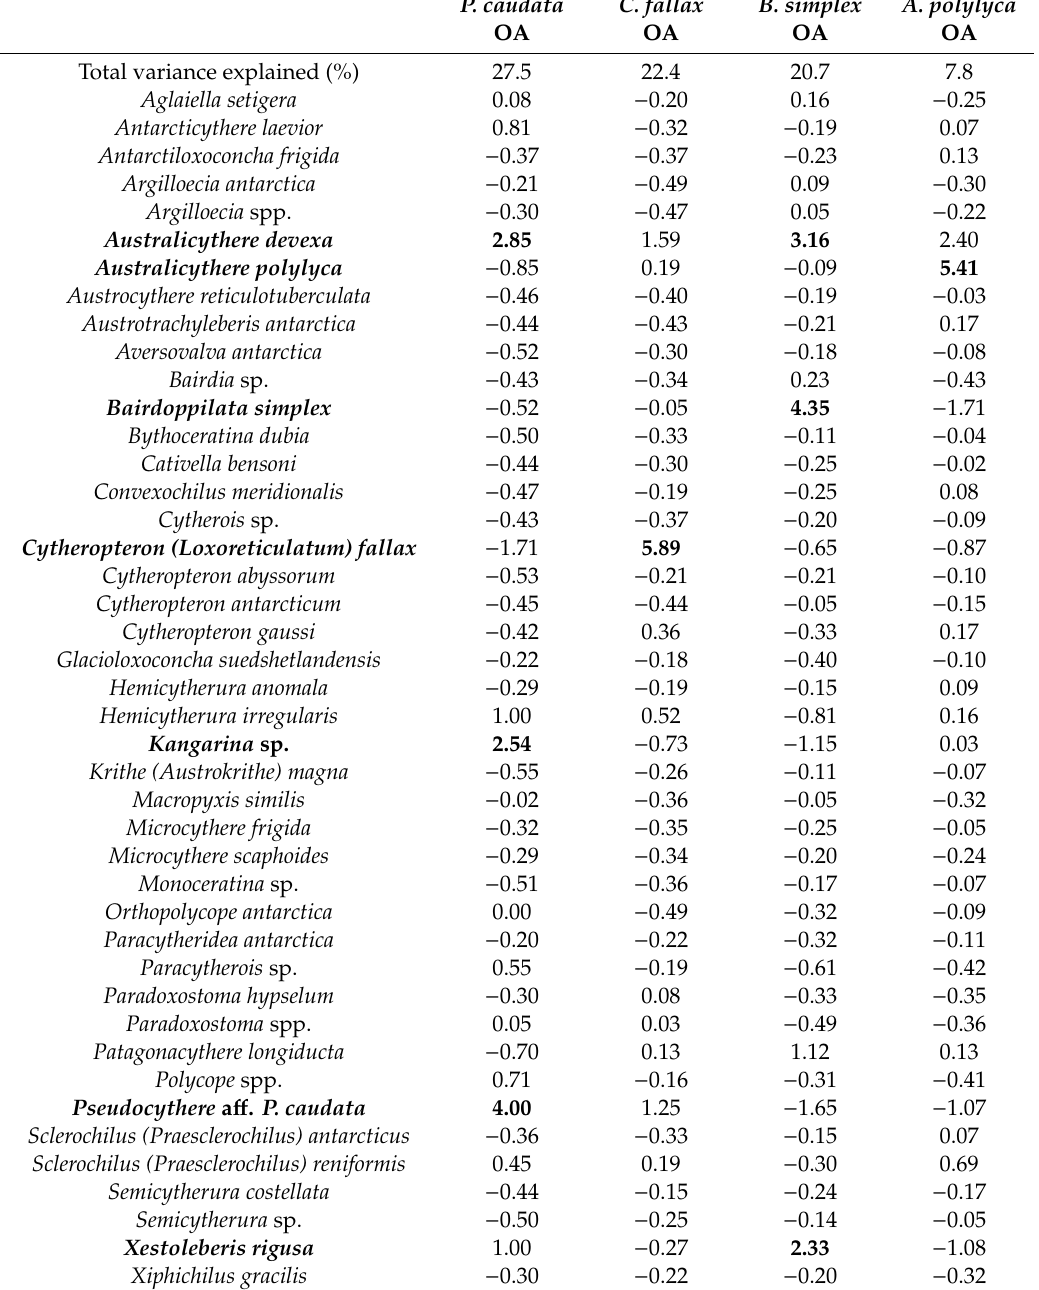
Table 3. Ostracods Principal Component scores (OAs). The dominant species for particular OA are reported in